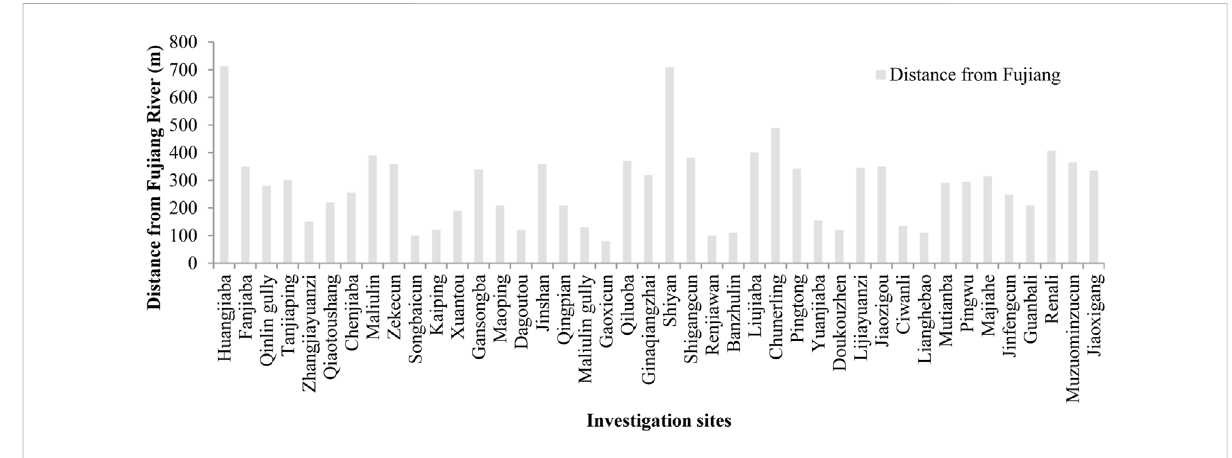
FIGURE 5 The distance of investigation sites from the main river in the Fujiang River upstream.